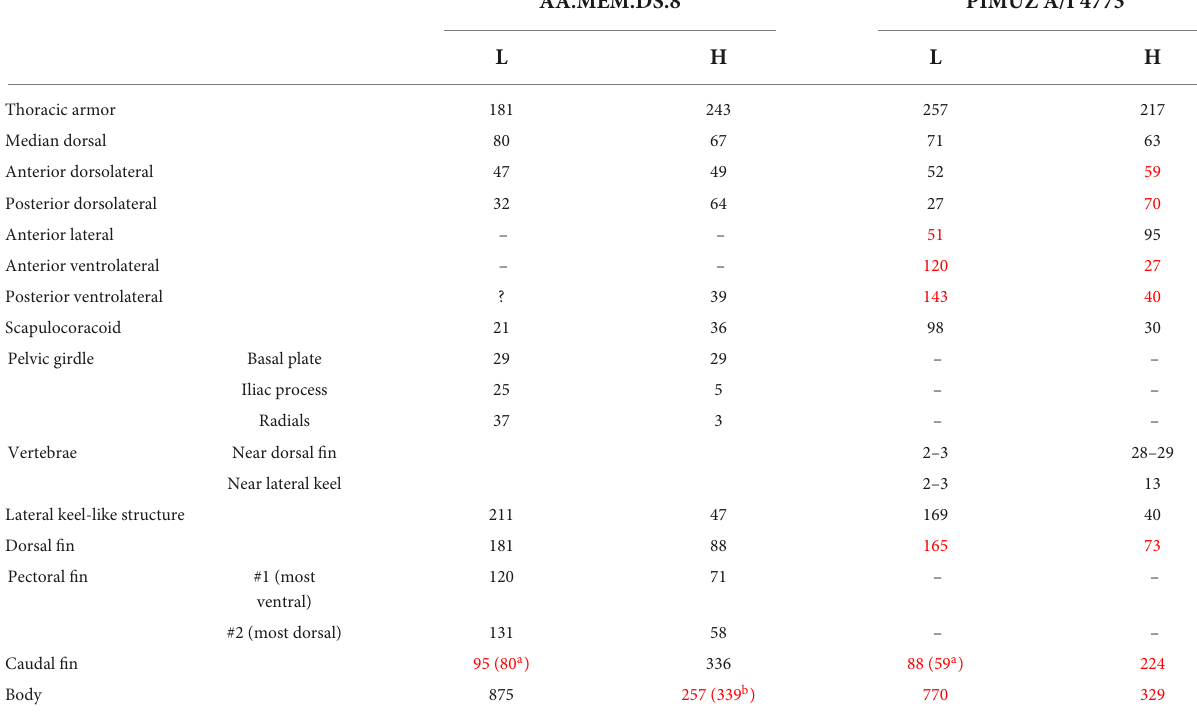
TABLE 2 Measurements of the postcranial elements of Amazichthys trinajsticae gen. et sp.